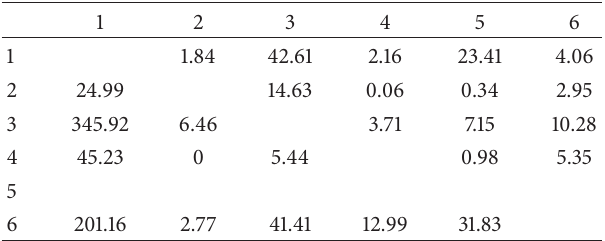
Table 4: Land use transformation matrix during 1988–2008 (unit: km 2